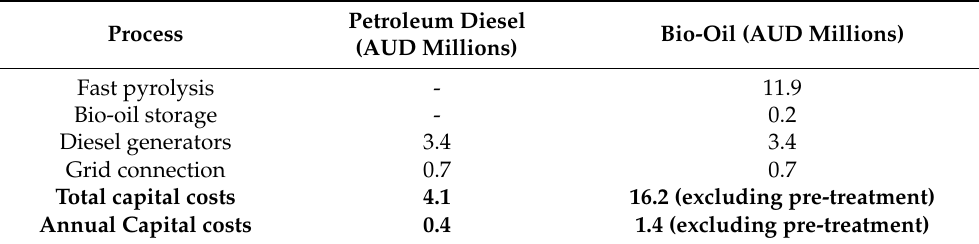
Table 2. Capital costs associated with running a diesel generator electricity plant with petroleum diesel and biomass converted to bio-oil fuel sources (exclusive of pre-treatment costs). All values are given in AUD millions. The annual capital costs were calculated using Equation (2).